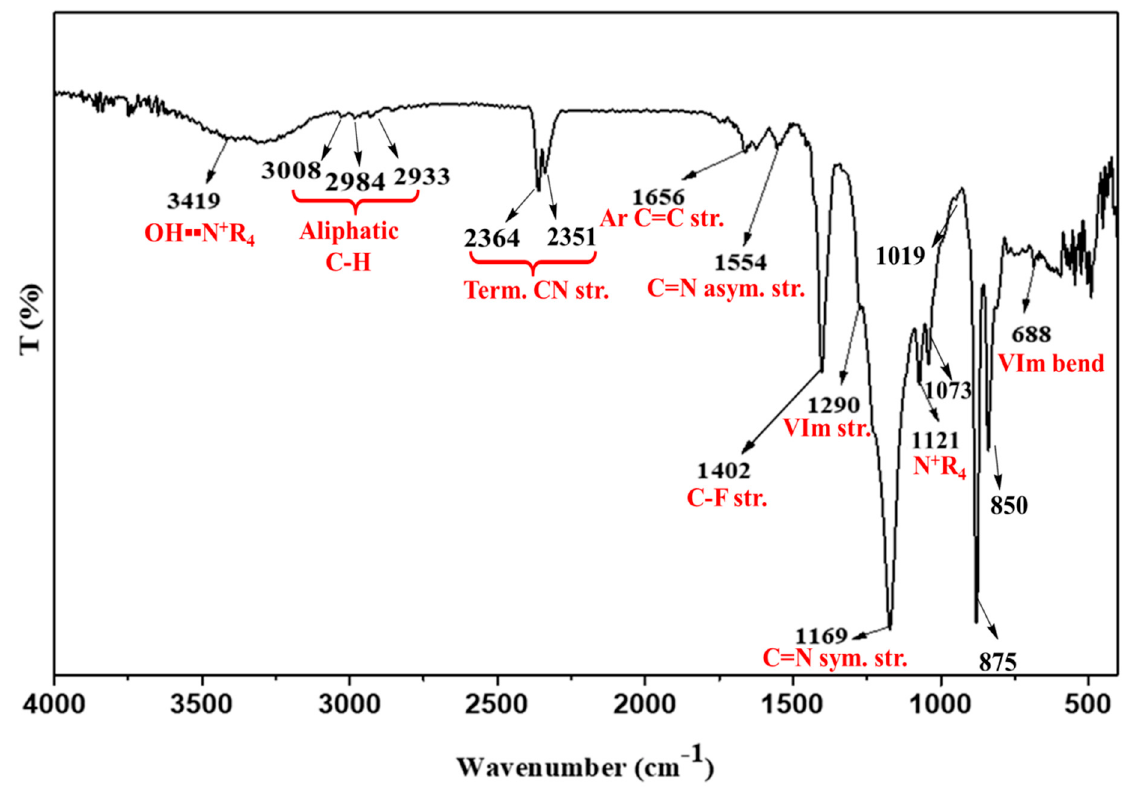
Figure 3. ATR-IR transmission spectrum of the PVIB anion-exchange membrane. Meanwhile, the peaks at 688 cm − 1 , 1073 cm − 1 and 1290 cm − 1 are assigned to the vinylimidazole bending and stretching modes, respectively, whilst the peaks at 1169 cm − 1 and 1554 cm − 1 are assigned to symmetric and anti-symmetric C=N stretches in the heterocyclic ring [39]. Finally, the peaks at 1121 cm − 1 , 1656 cm − 1 , 2352 cm − 1 , 2364 cm − 1 and 3419 cm − 1 confirm ionomer grafting: these peaks are attributed to the stretching modes of C-N + , aromatic C=C and O-H (bound water) associated with the quaternary ammonium groups [38,40]. Interestingly, the bands at 850 cm − 1 , 875 cm − 1 and 1019 cm − 1 additionally confirm the para-di-substitution and ring breathing of benzene, respectively [40]. No absorption bands at 960 or 1690 cm − 1 (indicative of free vinyl groups) were observed, showing that addition across the double bond is complete [41].